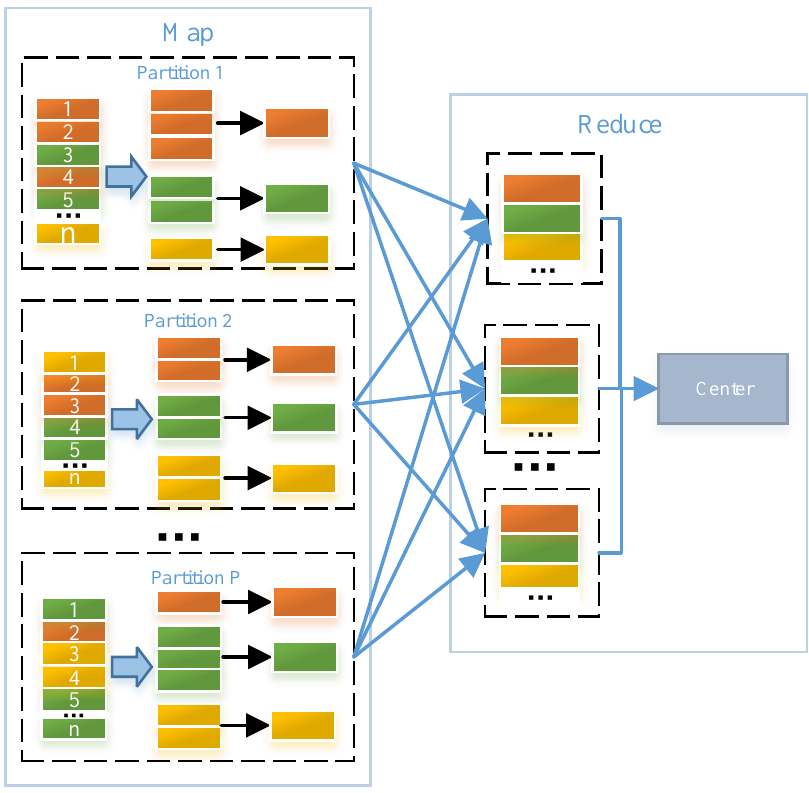
Figure 5. Data transmission after using the pre-merge